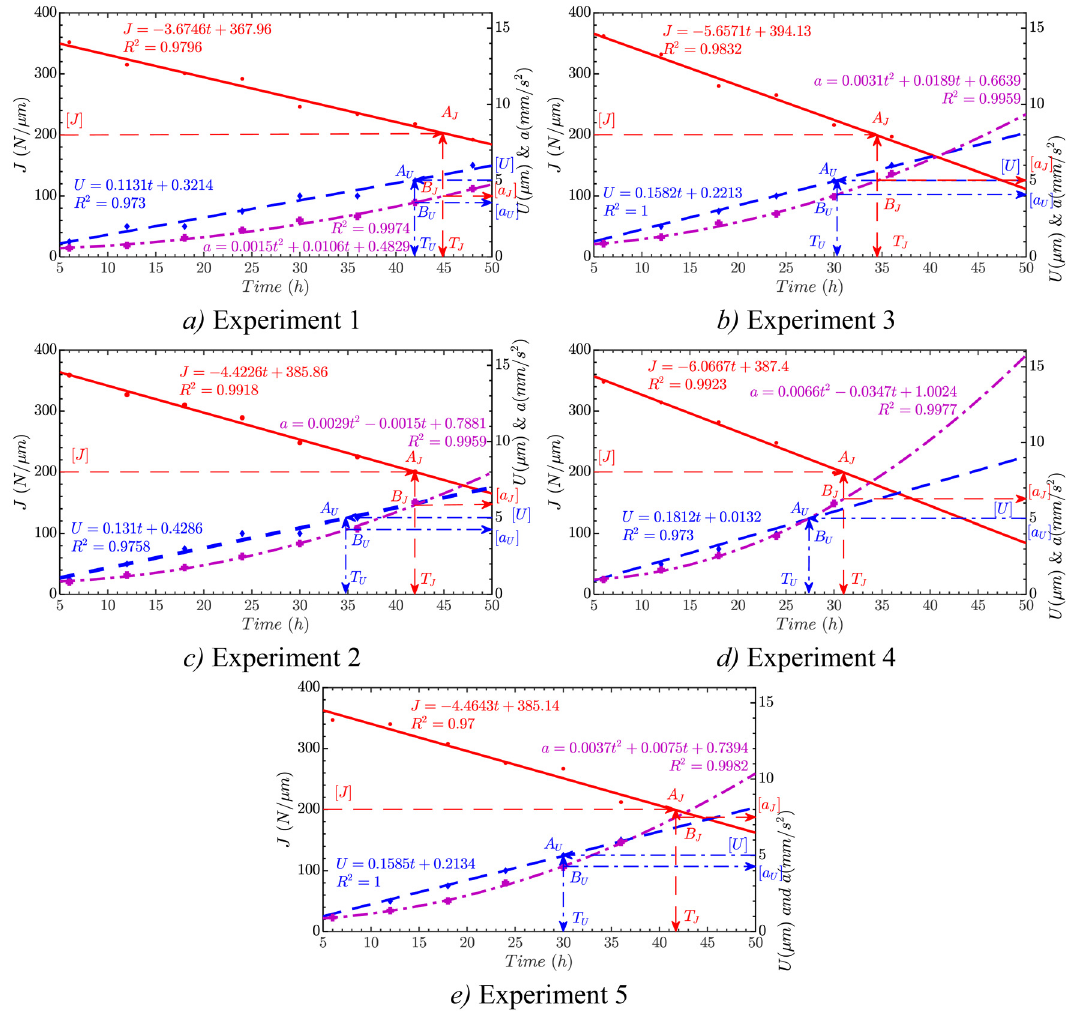
Fig. 5. Graphs of U , J , RMS over time of the Eclipse 300 CNC lathe spindle at different loading modes P and n